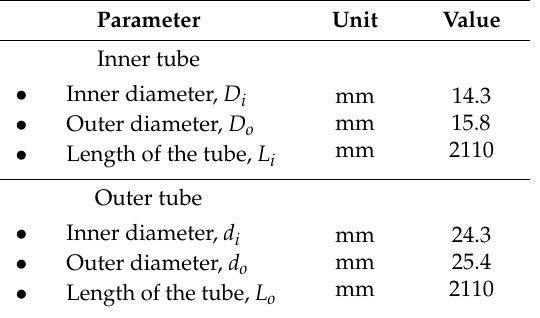
Table 1. Parameters in the present numerical